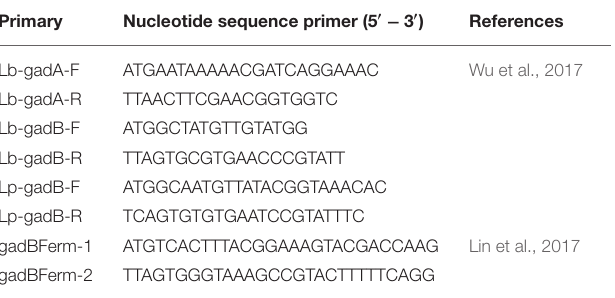
TABLE 1 | Primary sequences for gad gene detection.